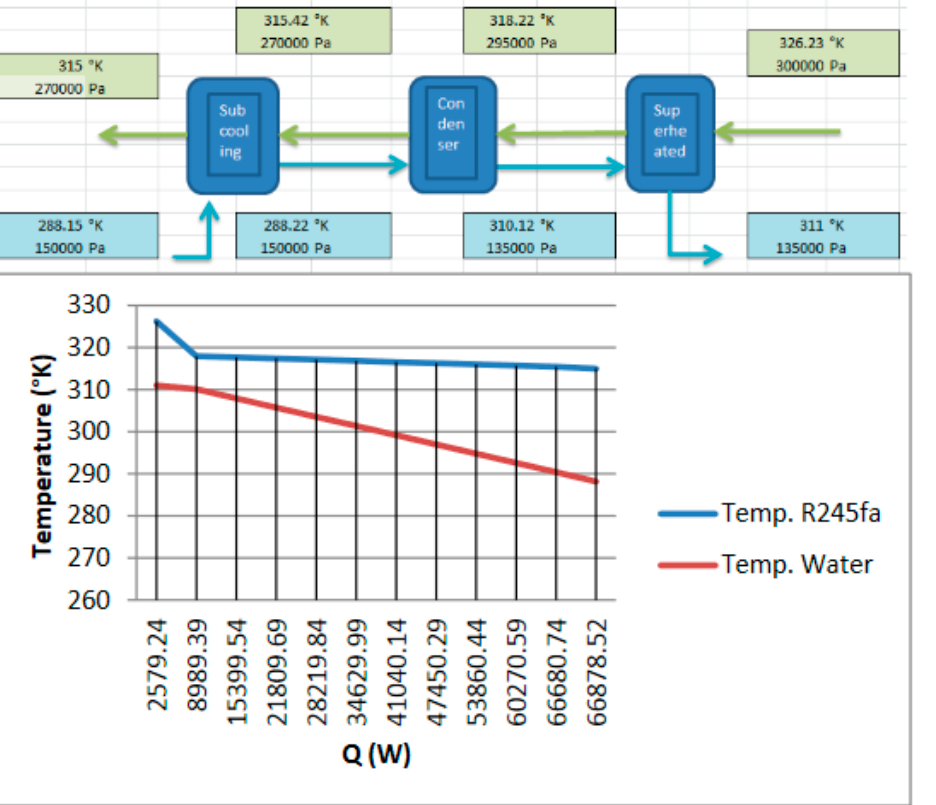
Figure 7. Thermal configuration and thermal exchange in the condenser. Table 5. Heat exchanged and exchange surface.